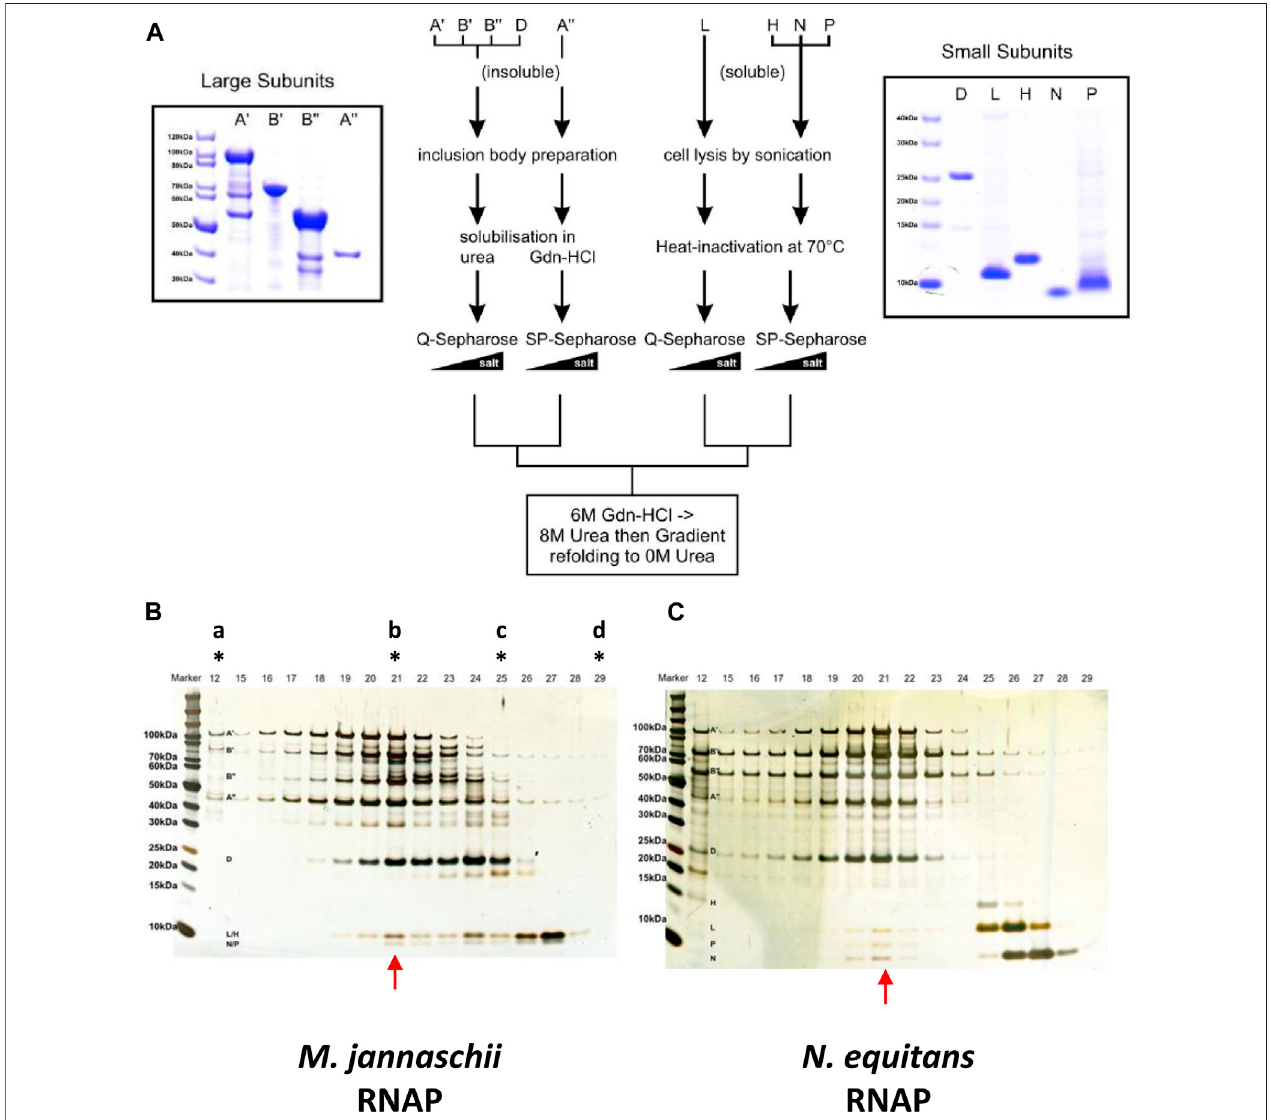
FIGURE4|(A) Overviewofthepuri fi cationof ne RNAPsubunits.Thecentralschemeoutliningthepuri fi cationprocedureforeachsubunitis fl ankedbyCoomassie- stainedgelsofthepuri fi edsubunits(left: ne A ′ , ne A ” , ne B ′ and ne B ” ;right: ne D, ne H, ne L, ne Nand ne P) (B) Elutionpro fi leofthe mj RNAP invitro assemblyreactionfroma Superose-6 size-exclusion column (similar to (Werner and Weinzierl, 2002)) shown on a silver-stained Bis/Tris 4 – 12% gradient SDS-protein gel. Fraction 21 (indicated with red arrow) contains the fully assembled enzyme (and peak transcriptional activity; data not shown) as revealed by the presence of all subunits within a single fraction.Theletterswithstarsontopshowthefractionswherethesizeexclusionmarkers( “ a ” ,BlueDextran2,000 kDa; “ b ” , ß -amylase200 kDa; “ c ” ,carbonicanhydrase 25 kDa; “ d ” , cytochrome c 12.4 kDa) eluted (C) Similar to (B), but for the ne RNAP in vitro assembly.